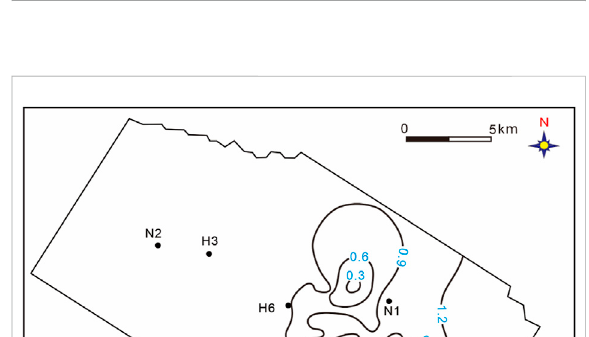
Stratigraphic column of Cretaceous in the H oil fi eld (after Simmons et al., 2007; Wang, 2016; Nasser, 2018; Al-Mimar et al., 2018; Zhang et al., 2021).